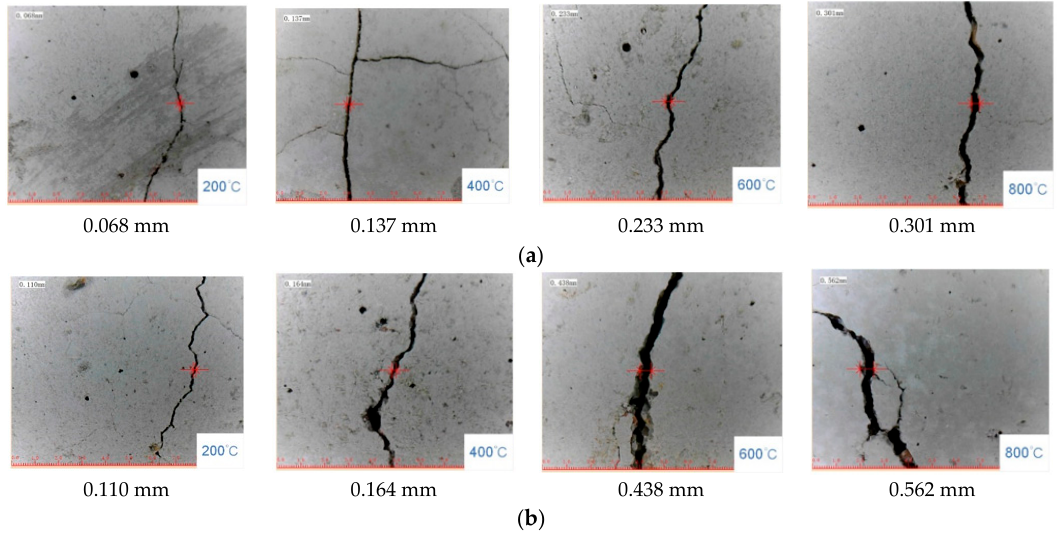
Figure 4. Maximum crack on the surface of specimens after high temperature: ( a ) SAC, ( b ) NC.